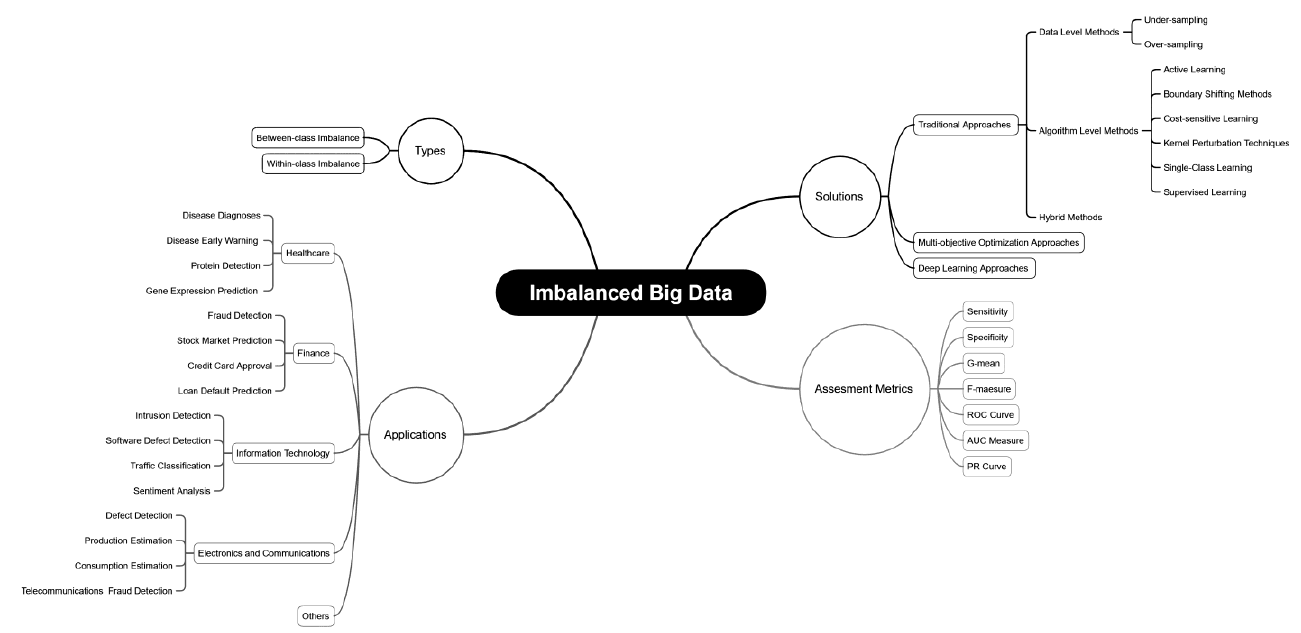
Fig. 1. Map of imbalanced big